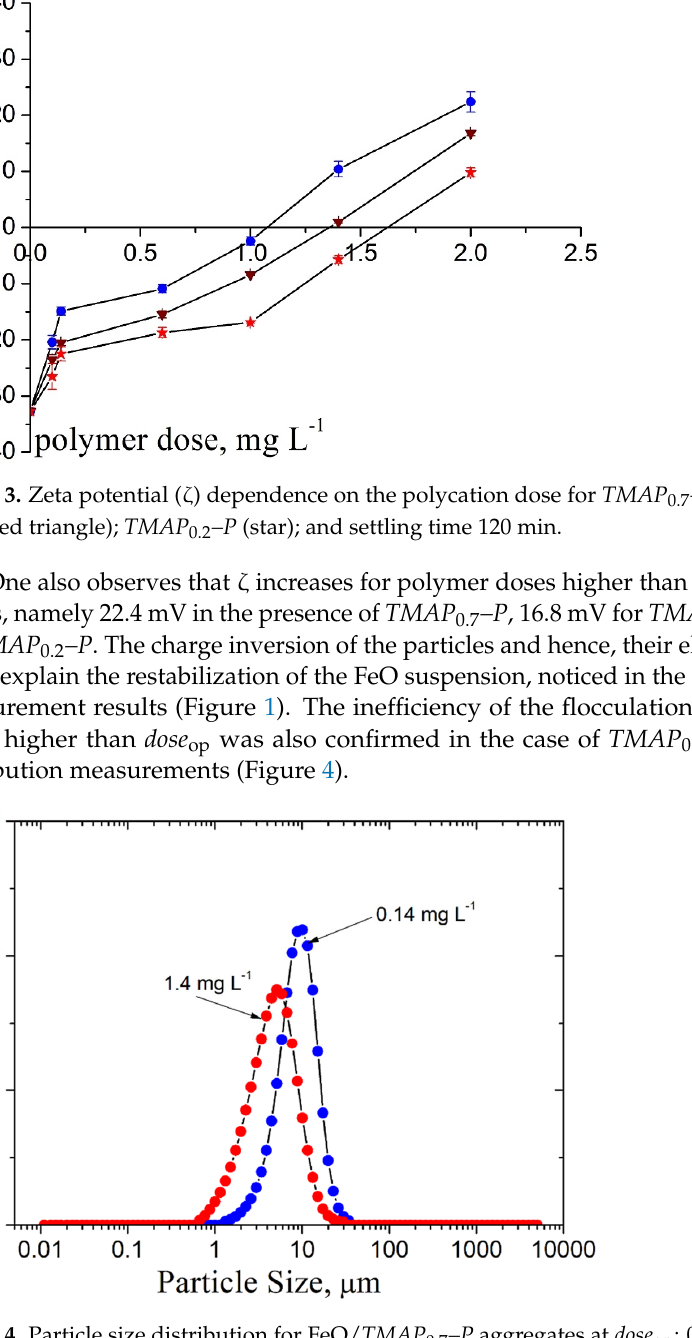
Figure 4. Particle size distribution for FeO/ TMAP 0.7 –P aggregates at dose op : 0.14 mg L ‐ 1 (red circle) and polymer dose: 1.4 mg L ‐ 1 (blue circle), settling time 120 min. The particle size distribution curves represent the mean value of the three independent measurements.